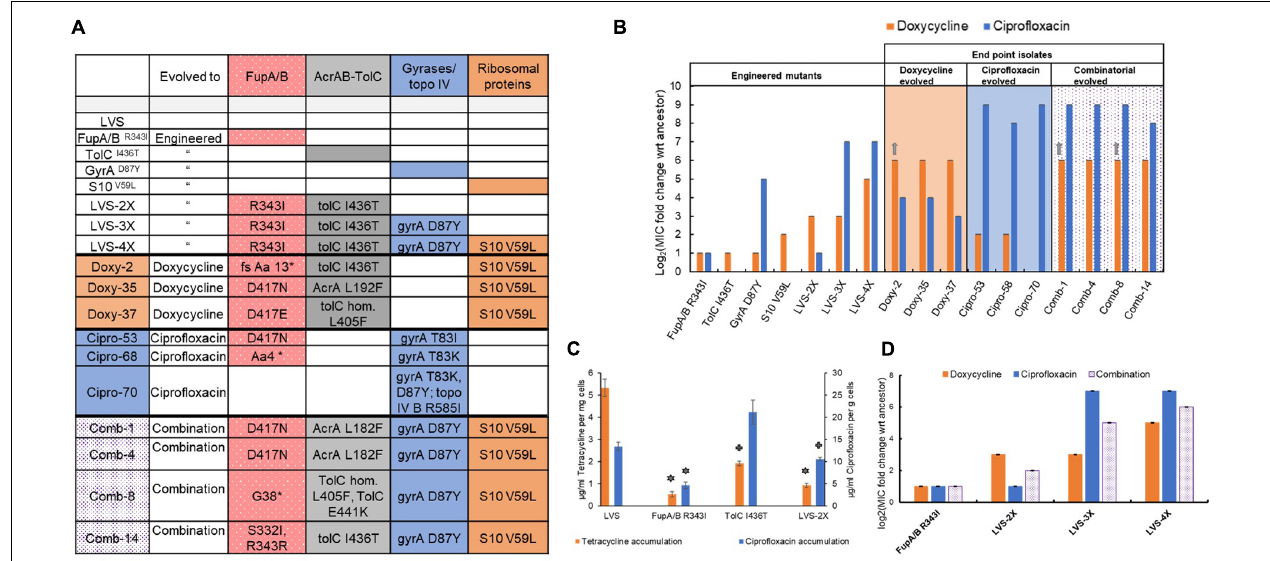
FIGURE 4 | (A) Genotypes of engineered mutants and selected end point isolates obtained from evolution studies. The individual adaptive steps of the most successful evolutionary trajectory of replicate population 3 (shown in Figure 5A ) was reconstructed via allelic exchange in the wild type LVS strain. For end point isolates, mutant alleles are only shown for genes implicated in resistance (full genotypes are included in Supplementary Datasets 1–5 ). (B,D) MIC values for the strains representing reconstructed steps toward adaptation (engineered mutants) and selected end point isolates are shown as log 2 fold change with respect to MIC of the wild type LVS strain. Bars indicate average of 3 biological replicates with error bars showing standard deviation. Gray arrows indicate that MIC value is greater than the highest antibiotic concentration tested. (C) Tetracycline and ciprofloxacin accumulation assay: Tetracycline (used as a proxy for doxycycline) accumulated in the wild type and mutant cells is denoted by orange bars on the primary Y-axis and ciprofloxacin accumulated is denoted by blue bars on the secondary Y-axis. Accumulated drug concentrations have been normalized by the wet weight of the cell pellets. Bars indicate average of 3 biological replicates and error bars denote standard deviation. Symbols above the bars denote statistical significance compared to wild type LVS (stars = p value < 0.005 and cross = p value < 0.05; two-tailed p value determined using Student’s t test for two samples assuming unequal